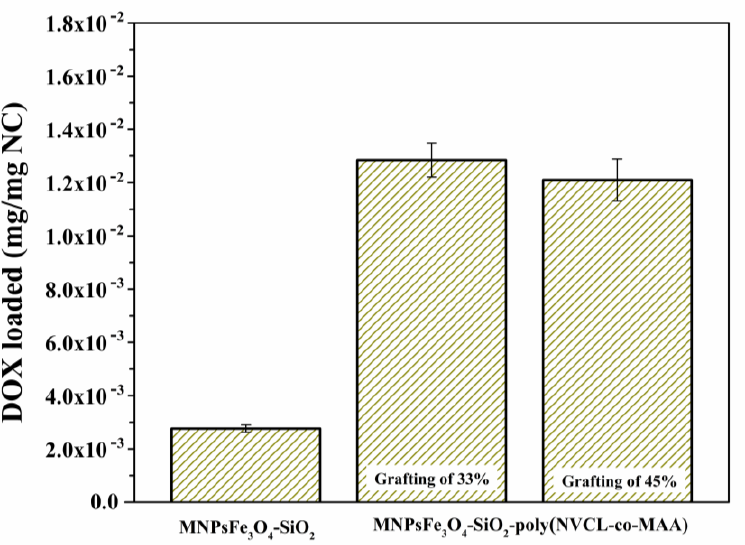
Figure 9. DOX loading capability of MNPsFe 3 O 4 -SiO 2 and MNPsFe 3 O 4 -SiO 2 -poly(NVCL-co- MAA) 33.45% nanocomposites.